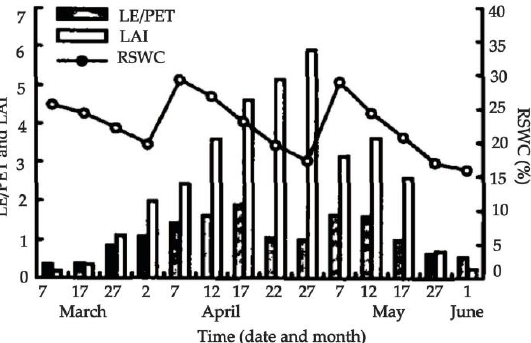
Figure 17. The variations of relative evapotranspiration (LE/PET) with leaf area index (LAI) and relative soil water content (RSWC) in the surface layer of winter wheat from turn–green to harvest (cited from the literature [42]).